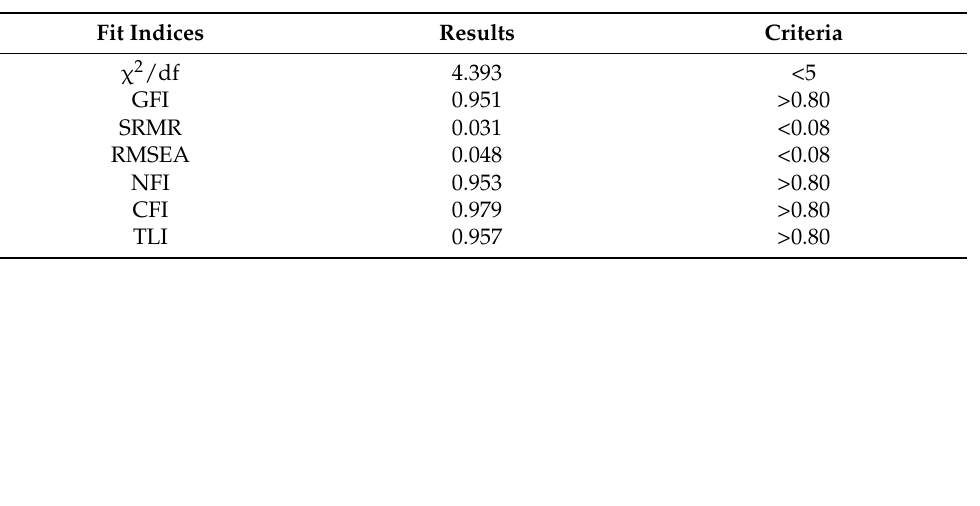
Table 7. Results of Goodness of Fit for